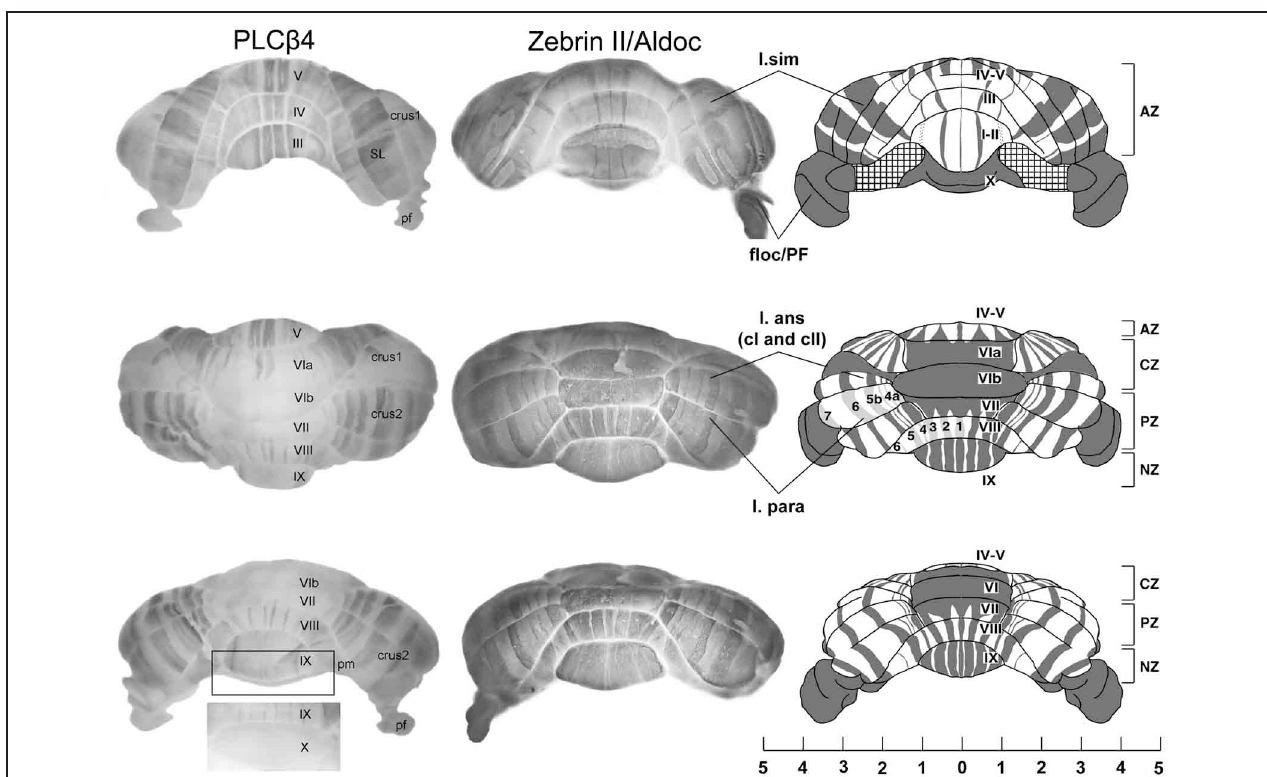
and paraflocculus; l. ans (c1 and c2), lobulus ansiformis, crus 1 and crus 2; l. para/pm, lobulus paramedianus; SL, lobulus simplex; AZ, anterior zone; CZ, central zone; PZ, posterior zone; NZ, nodular zone; lobules are indicated by Roman numerals (I–X). Scale bar is in mm [Adapted from Sarna et al. (2006) and Sillitoe and Hawkes